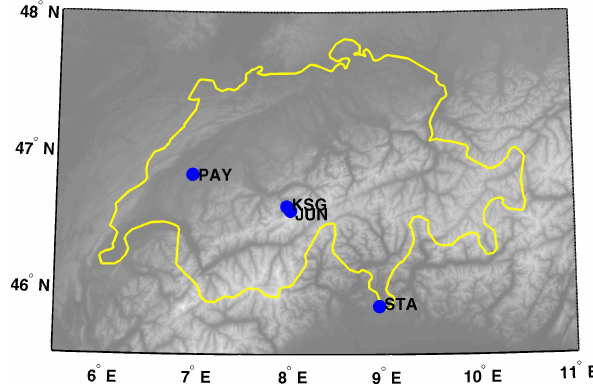
Fig. 1. Map of Switzerland with the four measuring sites of Payerne (PAY), Jungfraujoch (JFJ), Kleine Scheidegg (KSG) and Stabio (STA). The altitude is given by the grey color